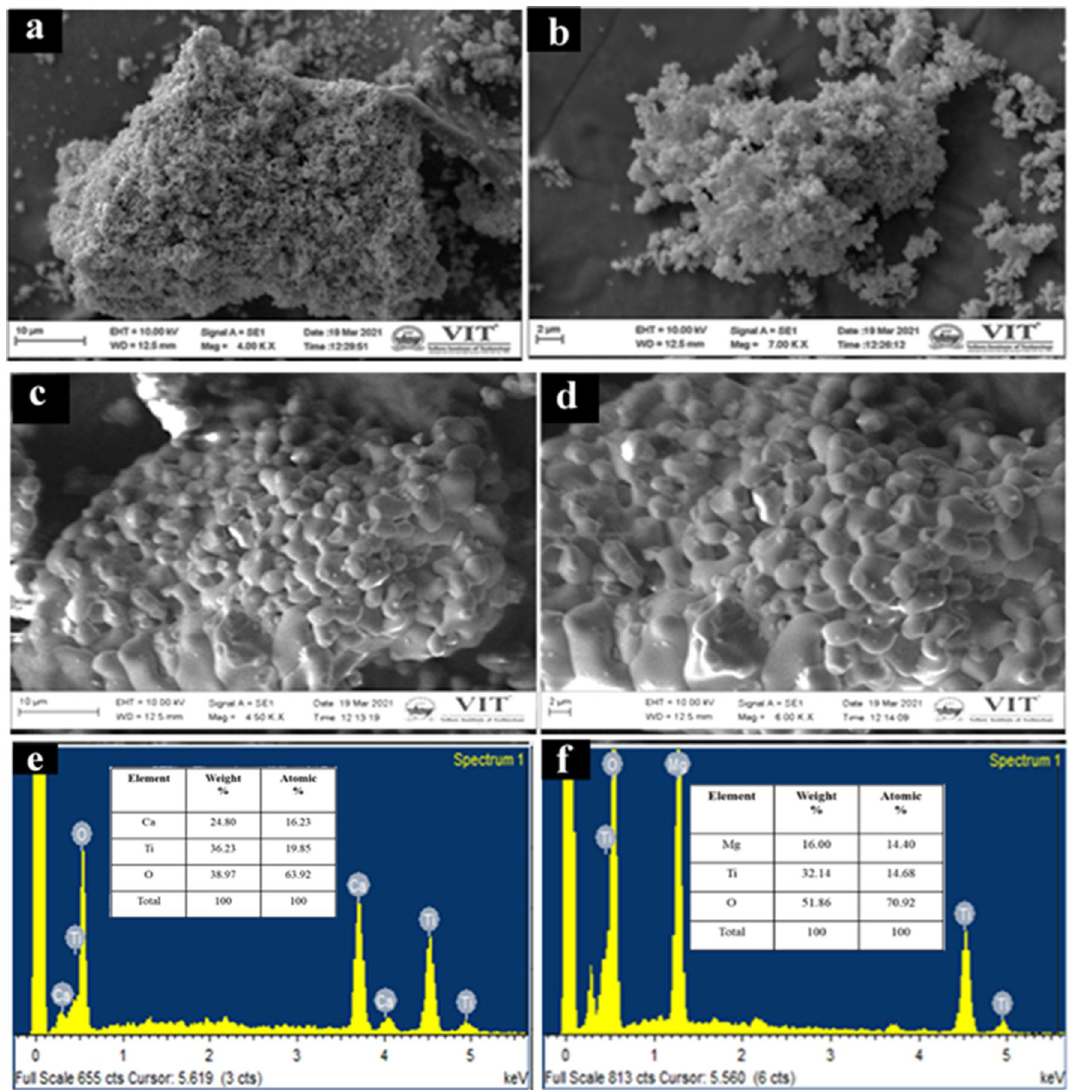
Figure 3. SEM micrographs of ( a,b ) CaTiO 3 and ( c,d ) MgTiO 3 and their corresponding EDX spectra are shown in ( e,f ),